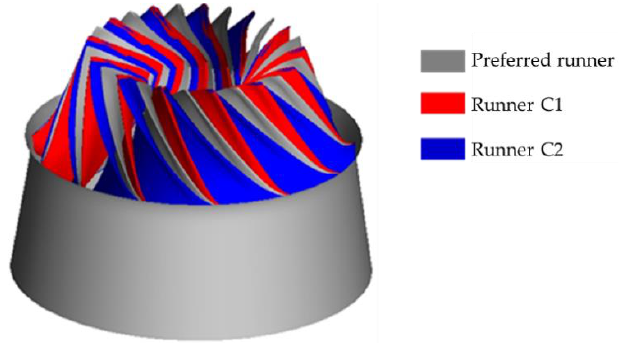
Figure 14. Geometry comparison for runners C1, C2 and the preferred runner.